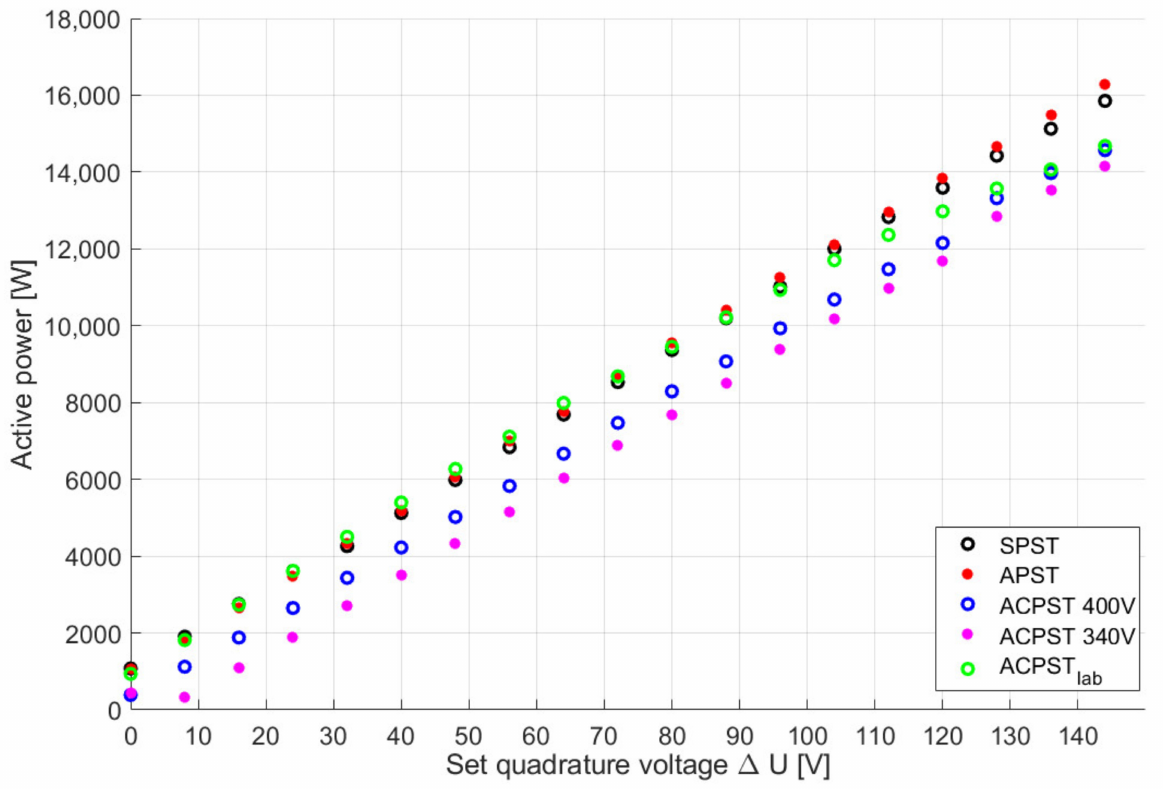
Figure 15. PSTs’ active power transfer as a function of the given quadrature